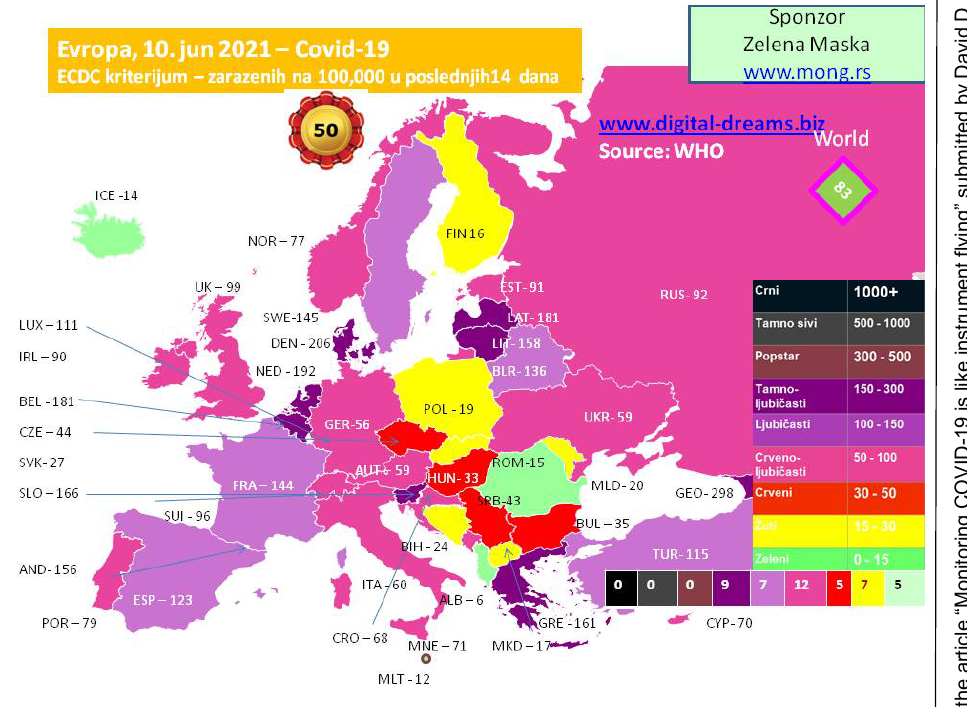
Figure 6 – INSTRUMENT 3: ECDC coefficient for each European country